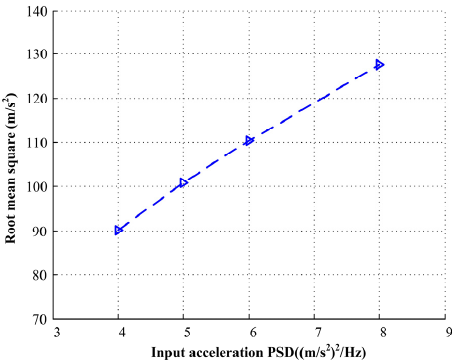
Figure 7. The root mean square (RMS) acceleration response under different input acceleration PSDs.